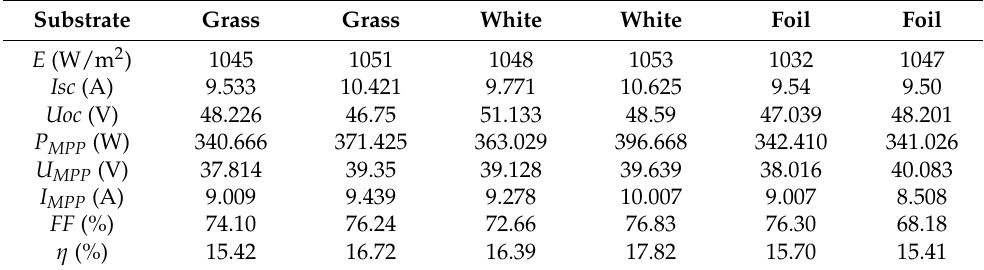
Table 9. The measurements results and calculations for 60° inclination of the module.